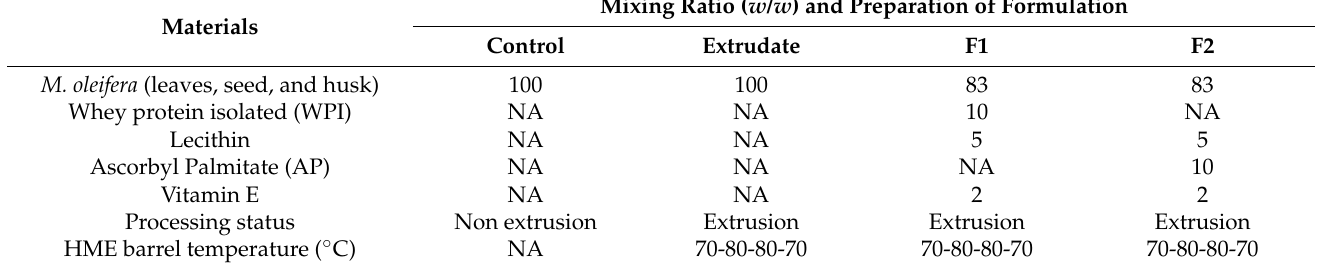
Table 1. The formulation composition of the extrudate M. oleifera (leaves, seed, and husk) and HME processing